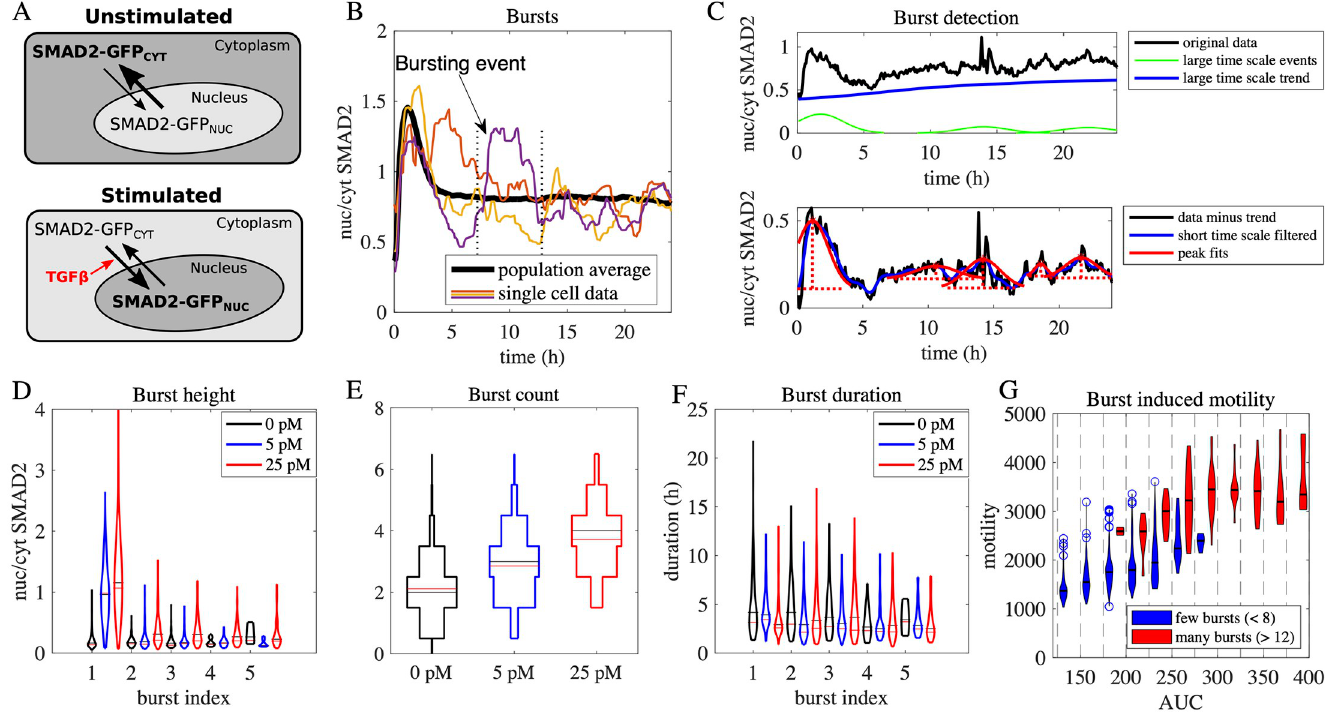
Fig 1. Quantification of bursts in TGF- β -induced SMAD translocation. A: Scheme of microscopy-based single-cell analysis of TGF- β signaling. In unstimulated cells the SMAD2-GFP fusion protein is primarily located in the cytoplasm (top). TGF- β stimulation promotes the transport of SMAD2-GFP to the nucleus and hence increases the nuc/cyt SMAD2 ratio that was quantified from microscopy images (bottom). See [7] for details on the data analysis. B: Bursts in SMAD2 nuclear translocation. Time-resolved measurements of the nuc/cyt SMAD2 ratio of four individual cells (colored lines) are compared to the population average response over 352 cells (black line) upon stimulation with 100 pM TGF- β . A stochastic deflection (burst) is highlighted (arrow, dotted lines indicate beginning and end). C: Burst detection process. Bursts are detected in the nuc/cyt SMAD2 ratio of a single-cell upon stimulation with TGF- β . Top: Peaks in the measured trajectory of the nuc/cyt SMAD2 ratio (black line) are approximated by a sum of Gaussian hills (green lines) which are subtracted from a smoothened version of the signal to estimate the long- term trend (blue line). Bottom: Afterwards, the long term trend is subtracted from the measurement data (black line), short-term effects are smoothed out by a Gaussian filter (blue line) and the result is analyzed by a peak finding algorithm which detects 5 bursts in this example (indicated in red). As pathway events might occur shortly after each other we allowed for overlapping bursts. The bursts are characterized by their height and duration (red dashed lines). See Methods for details. D: Burst height increases with TGF- β dose. Violin plots show the distributions of the burst height for the first 5 bursts (burst index) in the nuc/cyt SMAD2 ratio trajectories upon stimulation with 5 pM (blue) and 25 pM (red) TGF- β and in a control population (0 pM). Median and mean are marked by red and black horizontal lines. E: Burst count increases with TGF- β dose. Distribution of burst counts in the nuc/cyt SMAD2 ratio trajectories after stimulation with 5 pM and 25 pM TGF- β and in a control population (0 pM). Higher doses of TGF- β lead to higher burst counts. Median and mean are marked by red and black horizontal lines. F: Burst duration is independent of TGF- β dose. Violin plots show the distributions of burst duration for the first 5 bursts (burst index) in the nuc/cyt SMAD ratio trajectories upon stimulation with 5 pM and 25 pM TGF- β and in a control population (0 pM). Median and mean are marked by red and black horizontal lines. G: Bursts count correlates to cell motility at the single-cell level. Single cells were binned according to their area-under-curve (AUC), measured as the integral of the nuc/cyt SMAD2 ratio over all time points (x-axis), and were further sub-classified in terms of their total burst count (see legend). The cell motility (y-axis) was calculated by taking the sum over the distance moved by the cells in consecutive time points. Among cells with similar total signal (AUC), cells with 8 or less bursts (blue) exhibit lower motility than cells with 12 or more bursts (red).